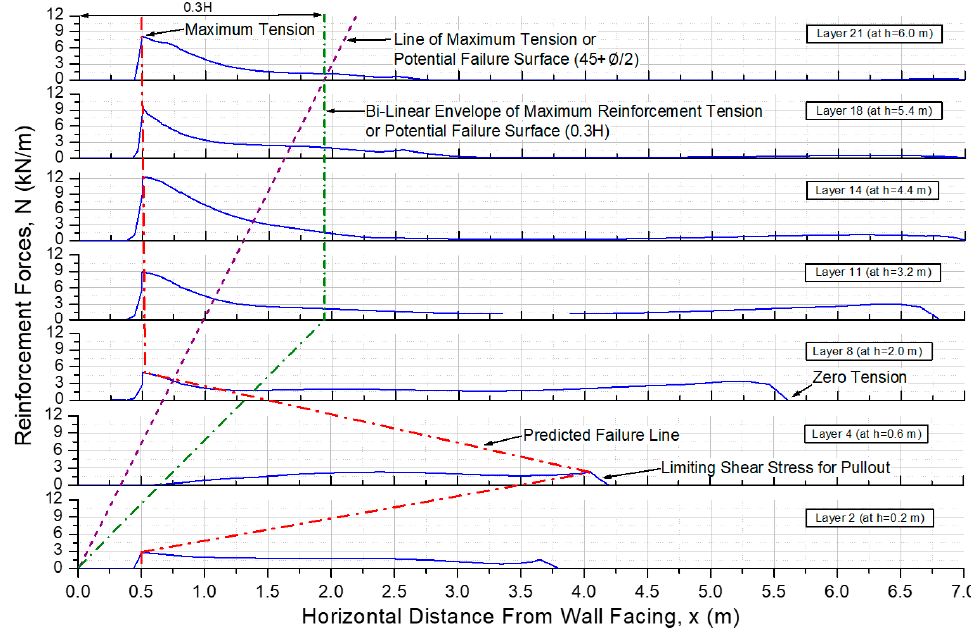
Figure 14. Distribution of reinforcement forces at seven elevations within the GRS abutment for Case 2.